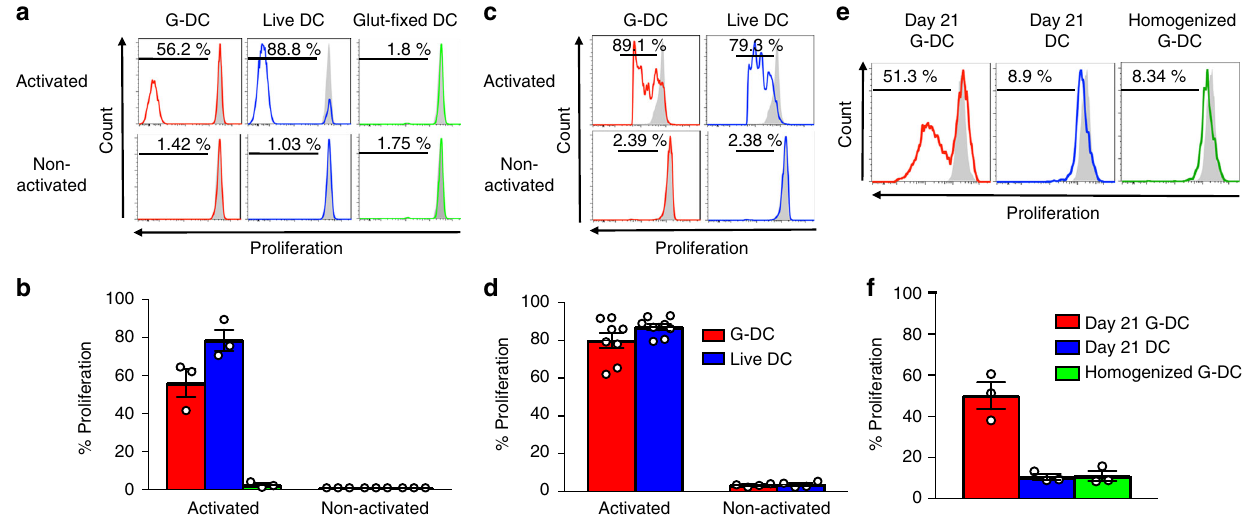
Fig. 7 Expansion of antigen-speci fi c T cells ex vivo and in vivo by G-DCs. a , b Antigen-speci fi c CD8 + T-cell stimulation by G-DCs, live DCs, and glutaraldehyde- fi xed DCs ex vivo. Error bars represent mean ± SEM. n = 3. c , d Antigen-speci fi c CD8 + T-cell stimulation by G-DCs and live DCs in vivo. Error bars represent mean ± SEM. ( n = 4 to 8). e , f G-DCs and non-gelated DCs were stored in PBS at 4 °C for 21 days (Day 21 G-DC and Day 21 DCs). In vivo antigen-speci fi c CD8 + T-cell stimulation was examined with day 21 G-DC, day 21 DCs, and day 21 G-DC structurally disrupted by ultrasonication (homogenized G-DCs). T-cell expansion was monitored on day 6. CFSE-labeled T-cell groups (gray) are shown as negative controls. Error bars